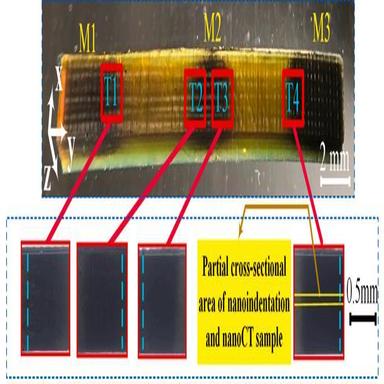
Printed bar samples with three magnets at different distances; the area marked with yellow box in T4 shows the cross-section of the sample used as FGM in further tests (For interpretation of the references to colour in this figure legend, the reader is referred to the web version of this article.).